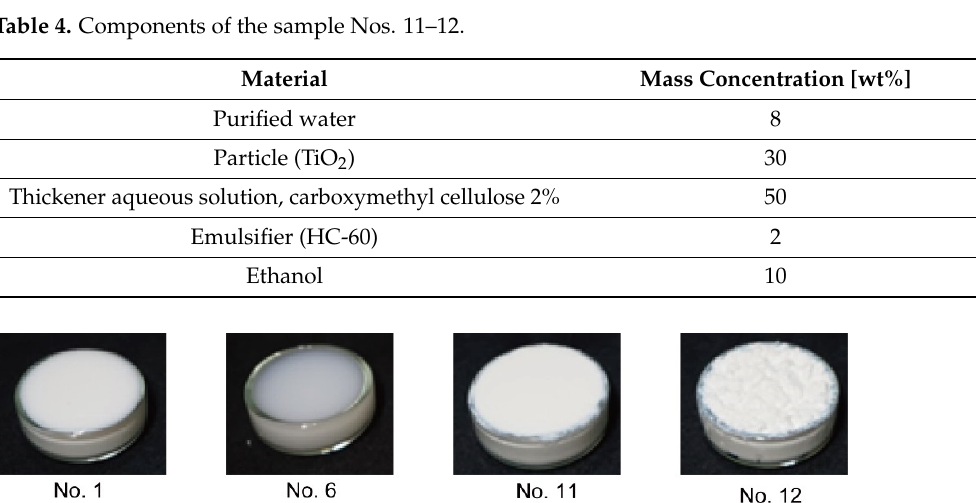
Figure 1. Photographs for examples of scattering medium used in sensory